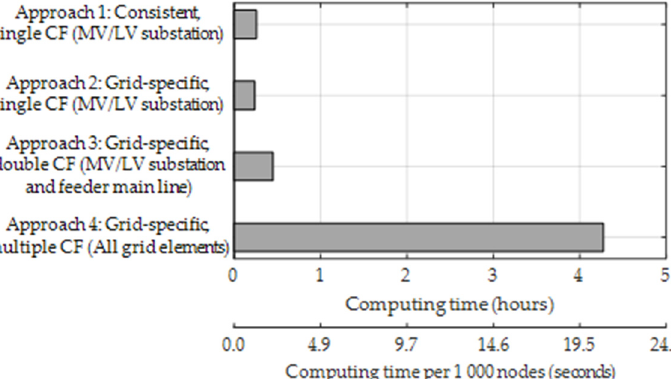
Figure 11. Comparison of different approaches to applying coincidence factors (CF) regarding the required computing time (7114 LV grids